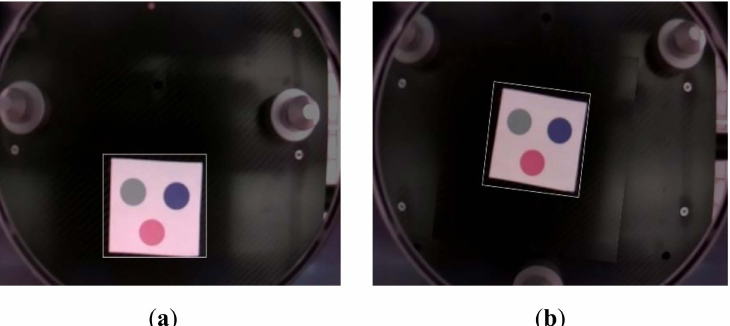
Figure 19. Marker recognition of position and angular errors for docking. ( a ) Position error occurs when docking with a marker. ( b ) Angle error occurs when docking with a